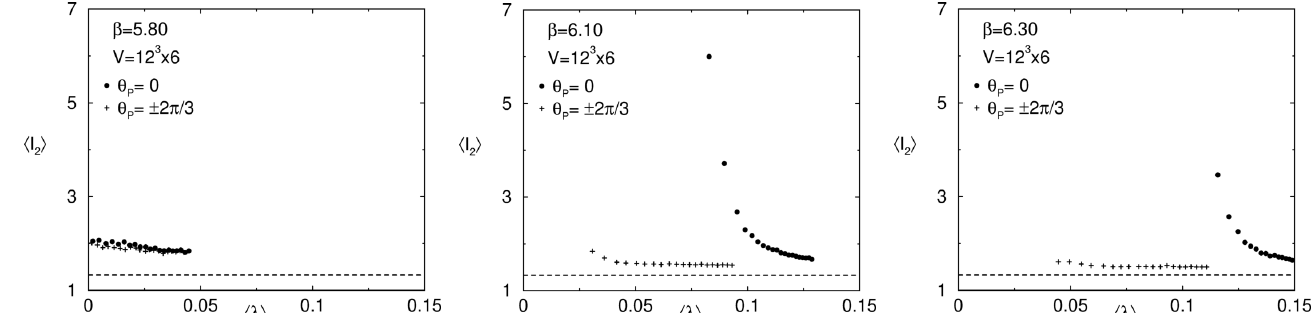
Figure 6. IPR of the low staggered modes on quenched configurations below ( left ), slightly above ( center ), and well above ( right ) the deconfinement transition for real ( θ P = 0) and complex ( θ P = (Reprinted figure with permission from M. Göckeler, P.E.L. Rakow, A. Schäfer, W. Söldner, and T. Wettig, Phys. Rev. Lett. 87, 042001 (2001). Copyright (2001) by the American Physical Society).